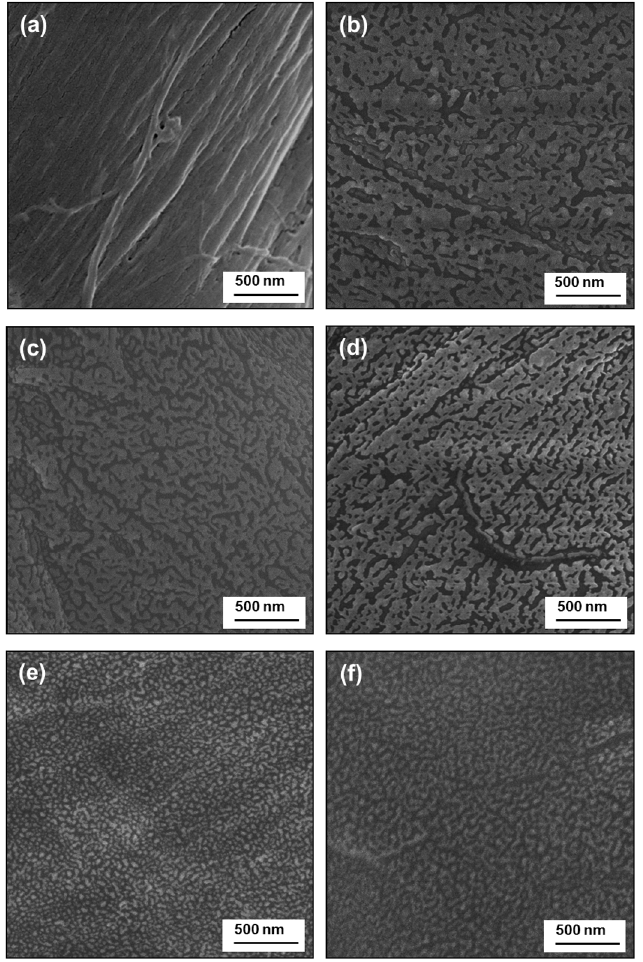
Fig 2. SEM images showing the surface morphology of untreated filter paper (a) and those modified with 0.2% OTS, 7:3 OTS/MTS with a total concentration of 0.2% (c), 0.2% MTS (d), 0.4% OTS (e), and 1% OTS (f),